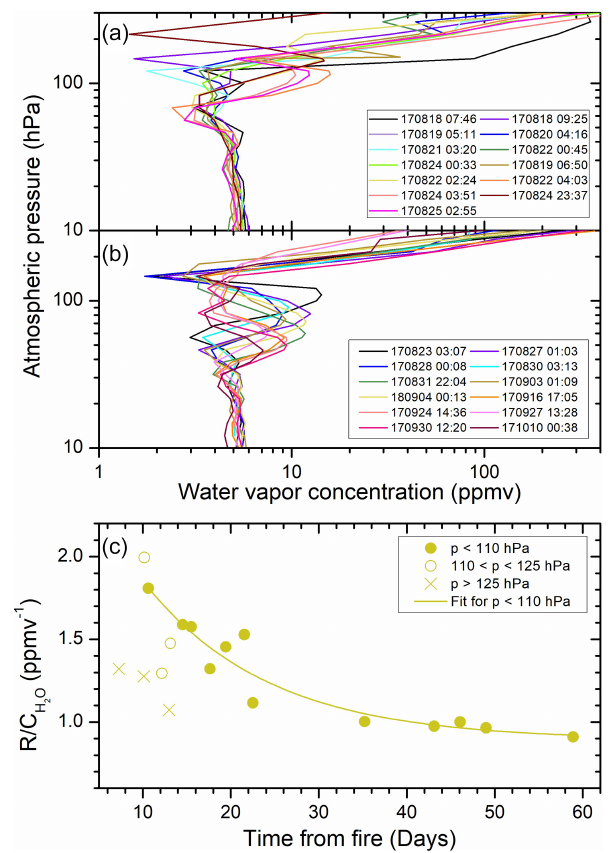
Figure 10. Water vapor in the smoke layer. Microwave Limb Sounder (MLS) measurements of water vapor concentrations (ppmv) vs. atmospheric pressure for smoke layers (a) close to the tropopause and (b) well above the tropopause (atmospheric pres- sure < 110hPa at the H 2 O peak) for individual smoke layers avail- able days 6–60 after the fire. (c) The peak scattering ratio ( R ) ac- cording to CALIOP divided by the peak water vapor concentration ( C H ) from MLS. The full line is an exponential fit ( R 2 = 0 . 88, 2 O P < 3 × 10 − 10 ) to smoke layers peaking in water vapor concen- tration at a pressure less than 110hPa. The half-life of the fit is 9 . 7 ± 3 .